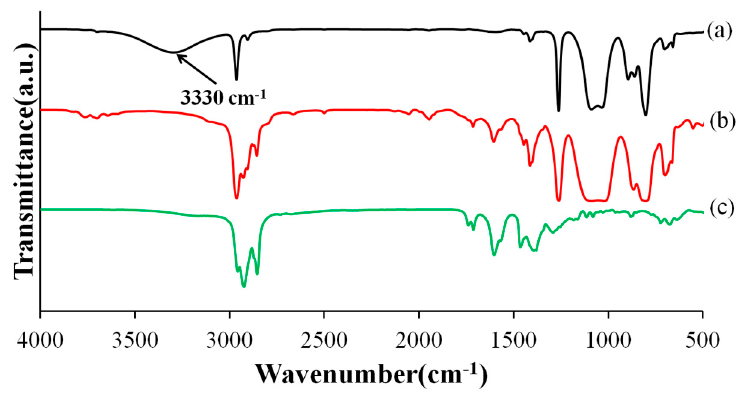
Figure 1. Infrared spectra of ( a ) a pristine STP; ( b ) a reaction product of STP/DD 10:1 mixture; and ( c ) DD.